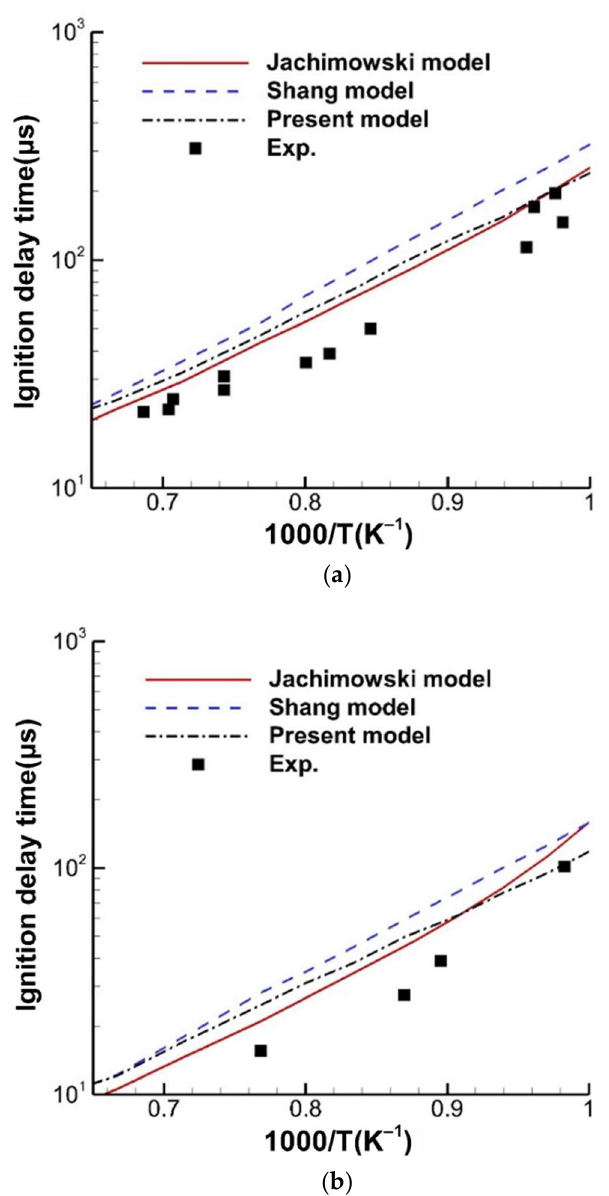
Figure 9. Ignition delay time varying with temperature at different initial pressures. ( a ) Initial pressure of 0.5 atm. ( b ) Initial pressure of 1 atm.